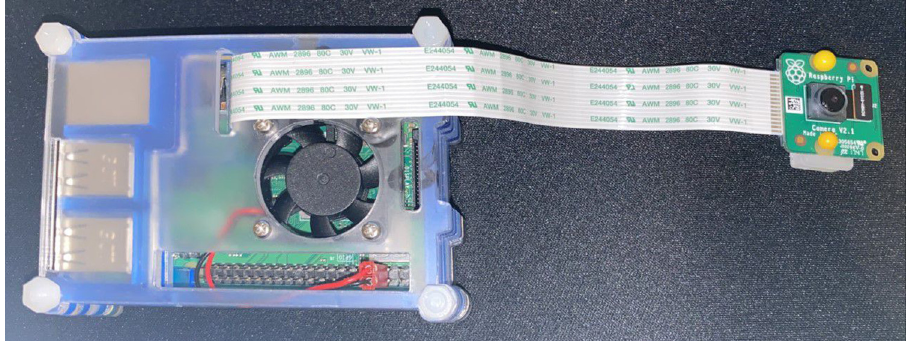
Figure 5: Hardware for the data collection and running detection